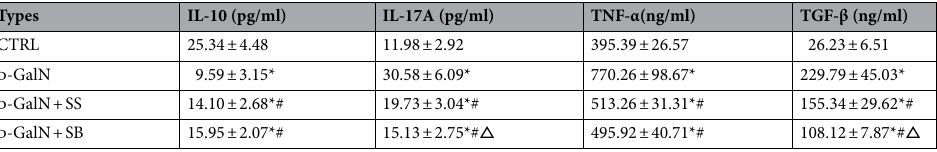
Table 1. The effects of fecal microbiota transplantation on serum IL-10, IL-17A, TNF-α, and TGF-β levels in mice. * P < 0.05 compared with control group. # P < 0.05 compared with d-GalN group. △ P < 0.05 compared with d-GalN + SS group.